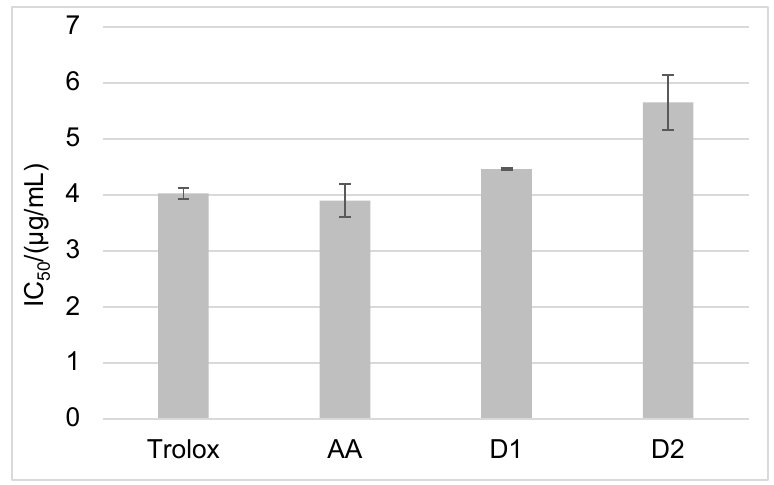
Figure 2. ABTS antioxidant activity of Trolox, AA, NH 2 AA (D1), and CH 3 NHAA (D2) on day 0. Results are expressed as µg/mL ± standard deviation (SD).